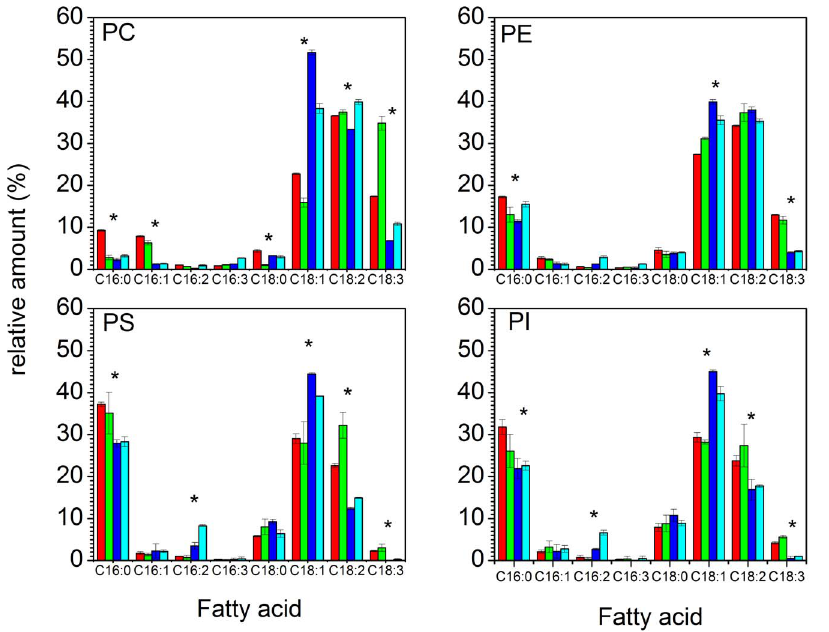
Figure 4. Fatty acid distribution of the main phospholipids produced by Pichiapastoris cells grown in a hydrogenated medium at 30 6 C (red) and at 18 6 C (green) and in a deuterated environment at 30 6 C (blue) and 18 6 C (cyan). In all individual phospholipids, the deuterated environment triggers the enrichment in C18:1 fatty acids PC, phosphatidylcholine; PE, phosphatidylethanolamine; PI, phosphatidyli- nositol; PS, phosphatidylserine. Errors bars represent the standard deviation from three different phospholipids extractions and separations. Data represent mean values 6 s.d (n=3). In histograms, * P , 0.05 from Student’s t -test, assuming equal variance. PC: for C16:0, the difference is significant between H30 u C and H18 u C, between H30 u C and D30 u C and between H30 u C and D18 u C. For C16:1, there is a significant difference between H30 u C and D30 u C and between H18 u C and D18 u C. For C18:0, there is a significant difference between H18 u C and D18 u C, between H18 u C and H30 u C and between H18 u C and D30 u C. For C18:1, the difference is significant between all the different temperatures and isotopic contents. For C18:2, there is a significant difference between D30 u C and D18 u C, between D30 u C and H30 u C and between D30 u C and H18 u C. For C18:3, the difference is significant between all the different temperatures and isotopic contents. PE: for C16:0, the difference is significant between H30 u C and D30 u C, between H30 u C and H18 u C and between H30 u C and D18 u C. For C18:1 and C18:3, the difference is significant between all the different temperatures and isotopic contents. PS and PI: for C16:0, there is a significant difference between H30 u and D30 u C and between H30 u and D18 u C. For C16:2 and C18:1, there is a significant difference between H30 u C and D30 u C, between H18 u C and D18 u C and between D18 u C and D30 u C. For C18:2 and C18:3, there is a significant difference between H30 u C and D30 u C and between H18 u C and D18 u